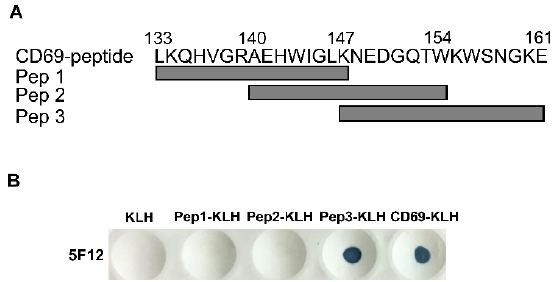
Figure 2. The identification of the epitope recognized by mAb 5F12 against CD69 by dot-ELISA. ( A ) Three overlapping peptides covering the CD69 polypeptide (aa 133–161) were synthesized and named Pep 1 (aa 133–147), Pep 2 (aa 140–154), Pep 3 (aa 147–161), an extra cysteine was added at the N terminus of each peptide for the conjugation of KLH. ( B ) These peptides were conjugated to KLH carrier and their reactivity with anti-poCD69 mAb 5F12 was determined by